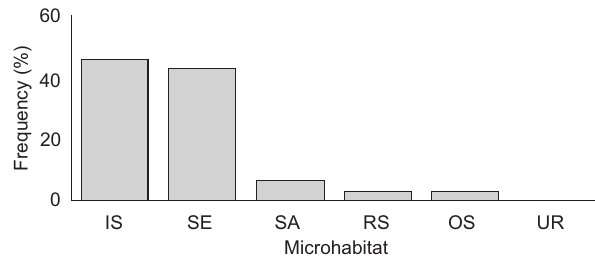
Figure 6. Frequency of the different types of microhabitats used by individuals of C. ocellifer at the Morro do Chapéu, Bahia, Brazil. (IS) Leaf litter inside shrubs, (SE) leaf litter at shrub edge, (SA) open sand, (RS) rocks covered by shrubs, (OS) leaf litter outside shrubs, (UR) uncovered rocks, N =